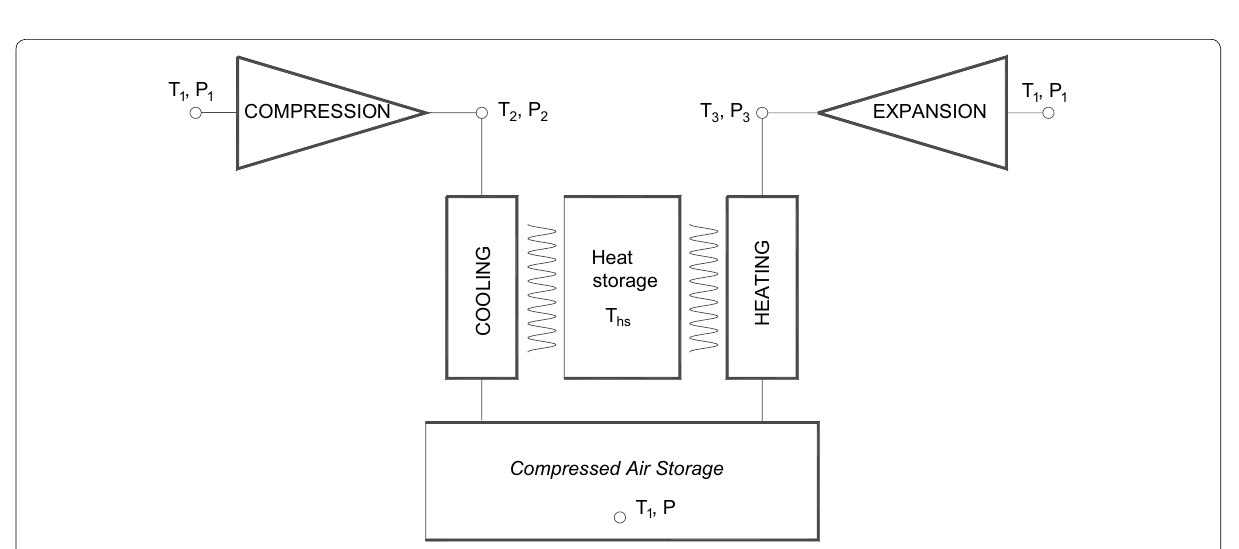
Fig. 2 Thermodynamic cycles of